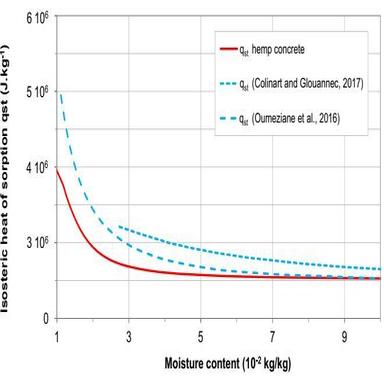
Calculated heat of sorption.